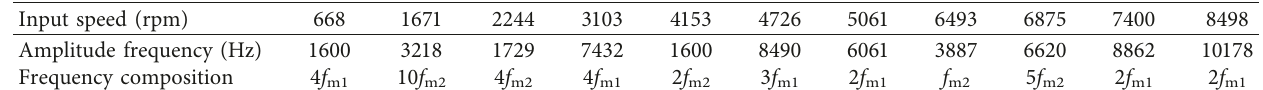
Figure 23: The effect of shaft stiffness on dynamic load amplitude: (a) k , (b) 4 k , (c) 6 k , and (d) 8 k . Table 6: Positions of fluctuating amplitudes of dynamic load of gear (Frequency